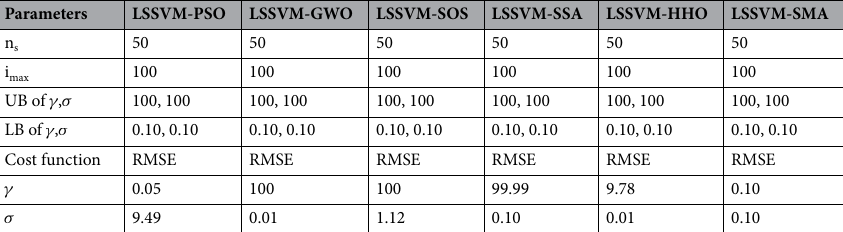
Table 3. Configuration of OAs for Set 2 hybrid LSSVMs.